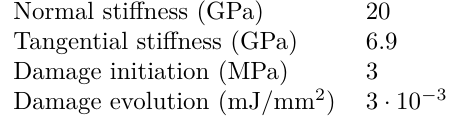
Table 2. Cohesive contact surface